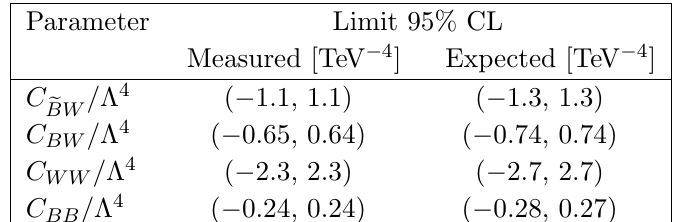
Table 9 . Observed and expected one-dimensional 95% CL limits on the C C WW = (cid:3) 4 and C BB = (cid:3) 4 EFT parameters, assuming that any excess in data over the SM expectation is due solely to a non-zero value of the parameter C each row, all parameters other than the one under study are set to